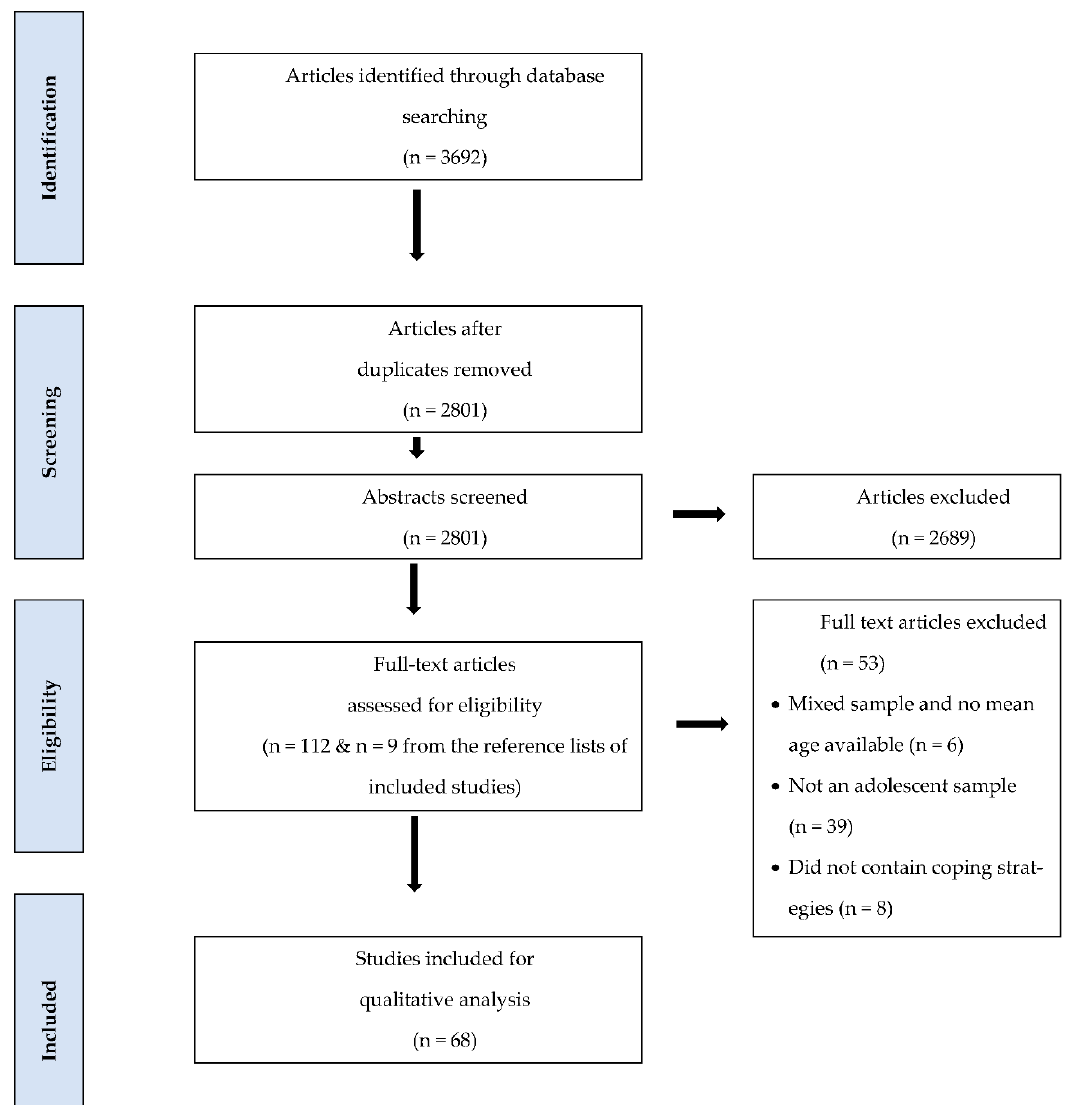
Figure 1. PRISMA flow diagram for scoping review.